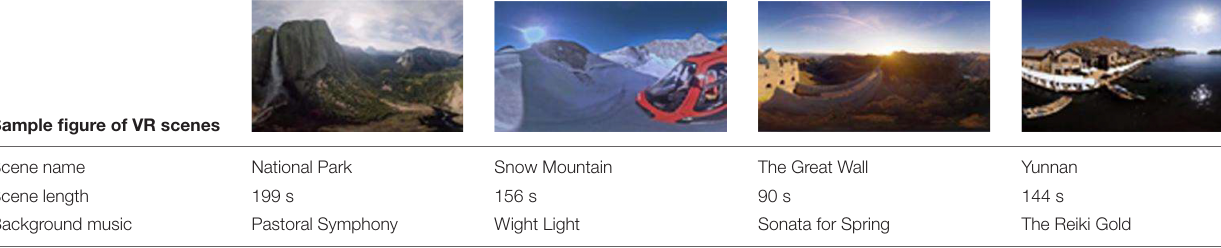
TABLE 1 | Selected VR relaxation scenes.